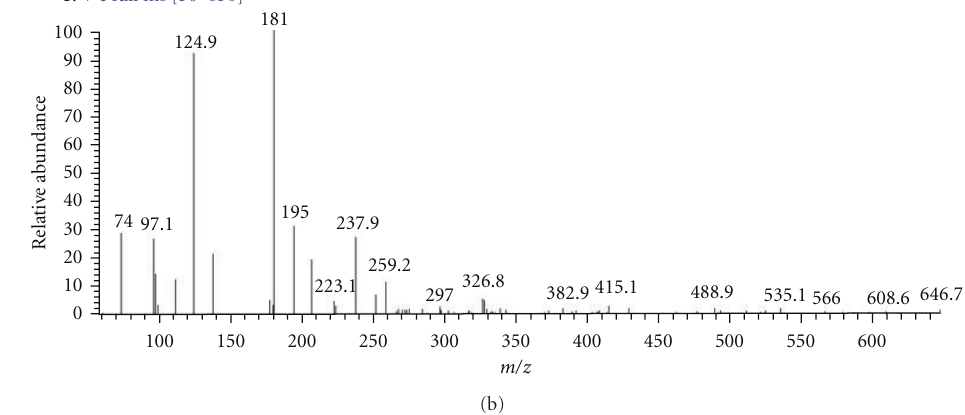
Figure 1: (a) Gas chromatogram of the PDP. (b) Mass fragmentation spectrum of PDP.